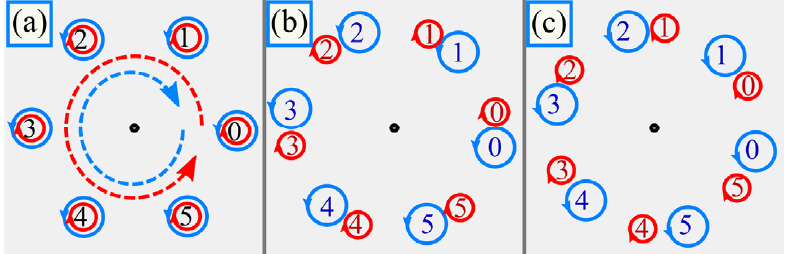
Figure 3. Evolution of the C-points in the light field (5). In the initial plane ( a ), polarization is linear, i.e., opposite C-points reside in the same points and compensate each other. When starting to propagate ( b ), C-points with right and left circular polarization rotate in the transverse plane in opposite directions. When approaching the next plane with linear polarization ( c ), given by Equation (23), C-points with right and left circular polarization merge again. The numbers 0–5 denote respective C-points, while red and blue color means respectively right and left circular polarization. Now, we try to determine where the SAM achieves zero or maximal magnitudes. If sin( m ψ ) > 0 in Equation (22), then the maximal and minimal SAM density is achieved, respectively, at the polar angles ϕ p = ( π + 4 π p )/(2 m ) and ϕ p = (– π + 4 π p )/(2 m ) with p = 0, . . . , m − 1, and these angles are independent of the propagation distance and on the singularities circle radius a 0 . However, after passing the planes with linear polarization and with the polarization singularities (Equation (23)), the angles of the maximal and minimal SAM density are swapped. Differentiating Equation (22) by r yields that at a fixed propagation distance z and at the angles ϕ p , maximal SAM density is achieved on a circle with the radius